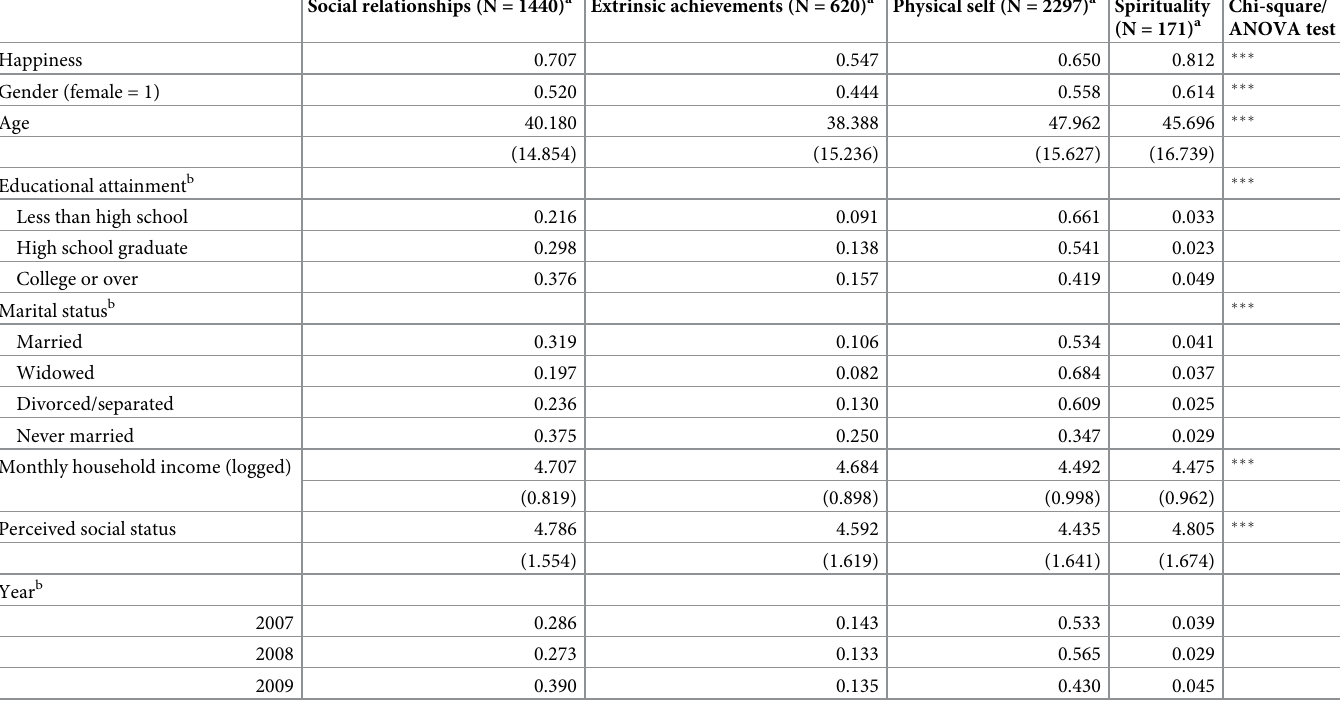
Table 2. Descriptive statistics for all variables across values on life domains and the results of Chi-squared/ANOVA tests comparing variables across the life